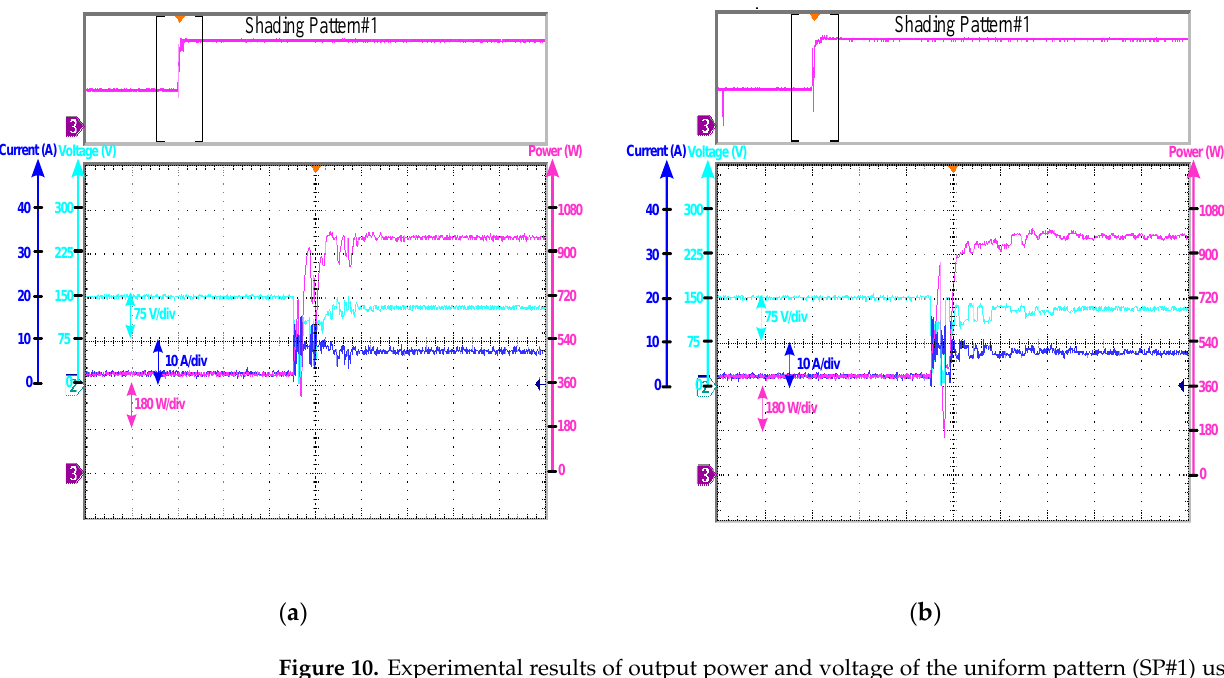
Figure 10. Experimental results of output power and voltage of the uniform pattern (SP#1) using: ( a ) CSO; ( b ) PSO.